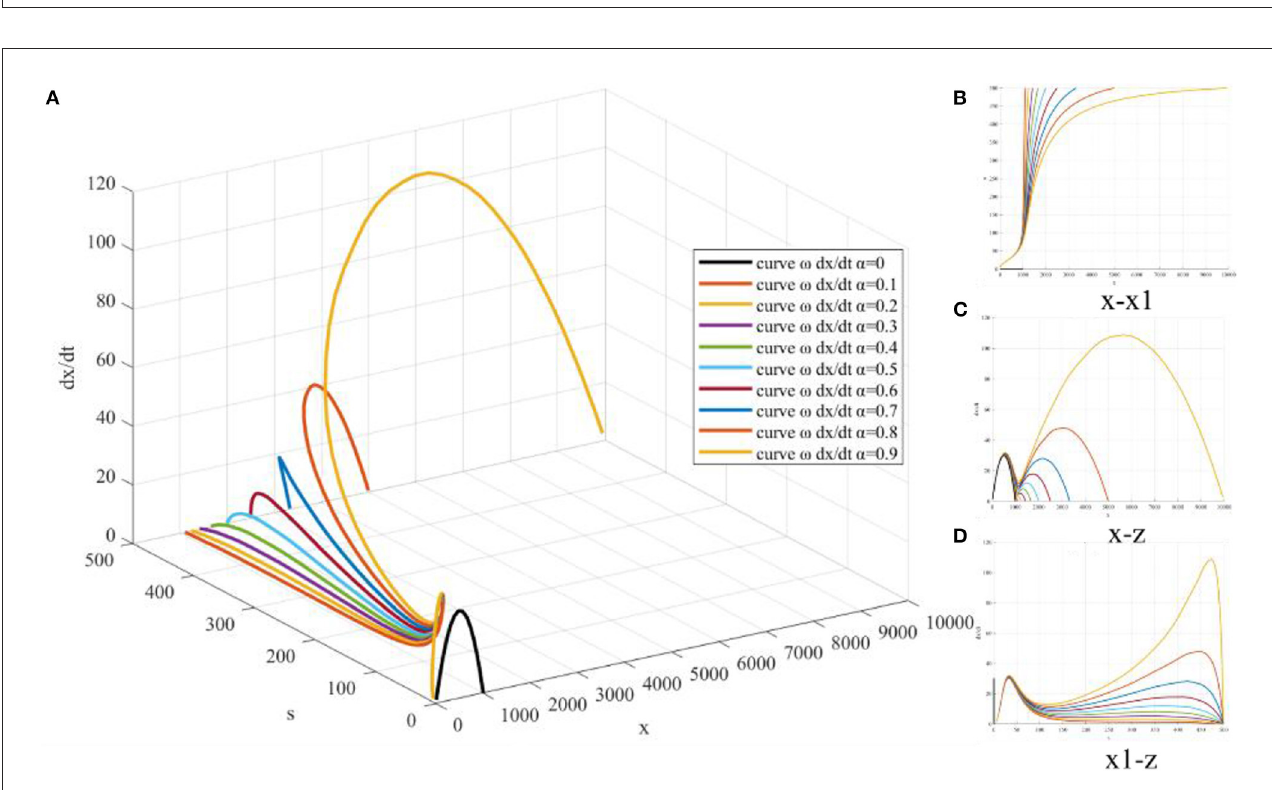
FIGURE8 Simulation based on stationary point parameter α .